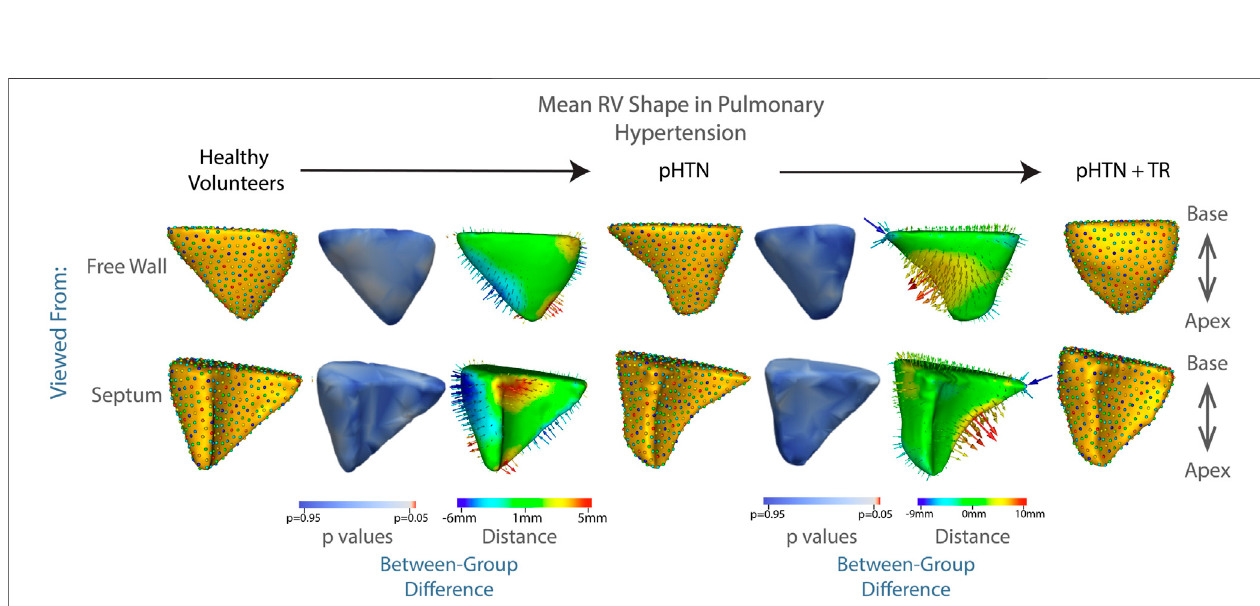
FIGURE 6 | The mean shape of the right ventricle in healthy volunteers, patients with pulmonary hypertension, and patients with pulmonary hypertension plus moderate or greater TR are shown in columns 1,4,7. Columns 3 and 6 show the difference between the group mean shapes. The arrows indicate the direction of group differences, and the color represents the magnitude of the group difference. Columns 2 and 5 show the p -values of the group differences. The regions with red color showcase statistically signi fi cant group differences.